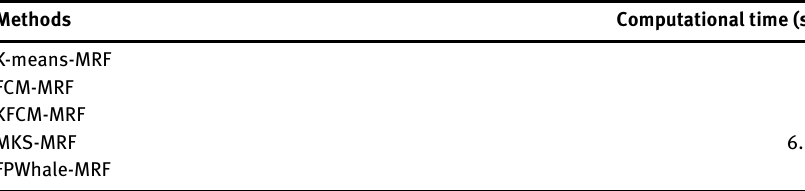
Table 2: Computational Time of the Comparative Methods.